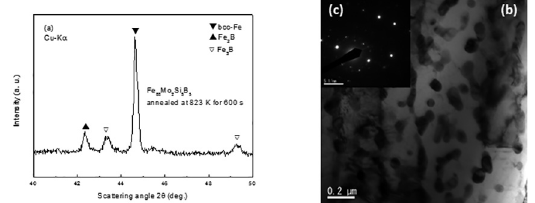
Figure 6: (a) High resolution XRD patterns (Cu-Kα) and (b) Bright- field image with corresponding (c) selected area electron diffraction pattern of Fe Mo Si B ribbon after annealing at 823 K for 600 88 2 5 5